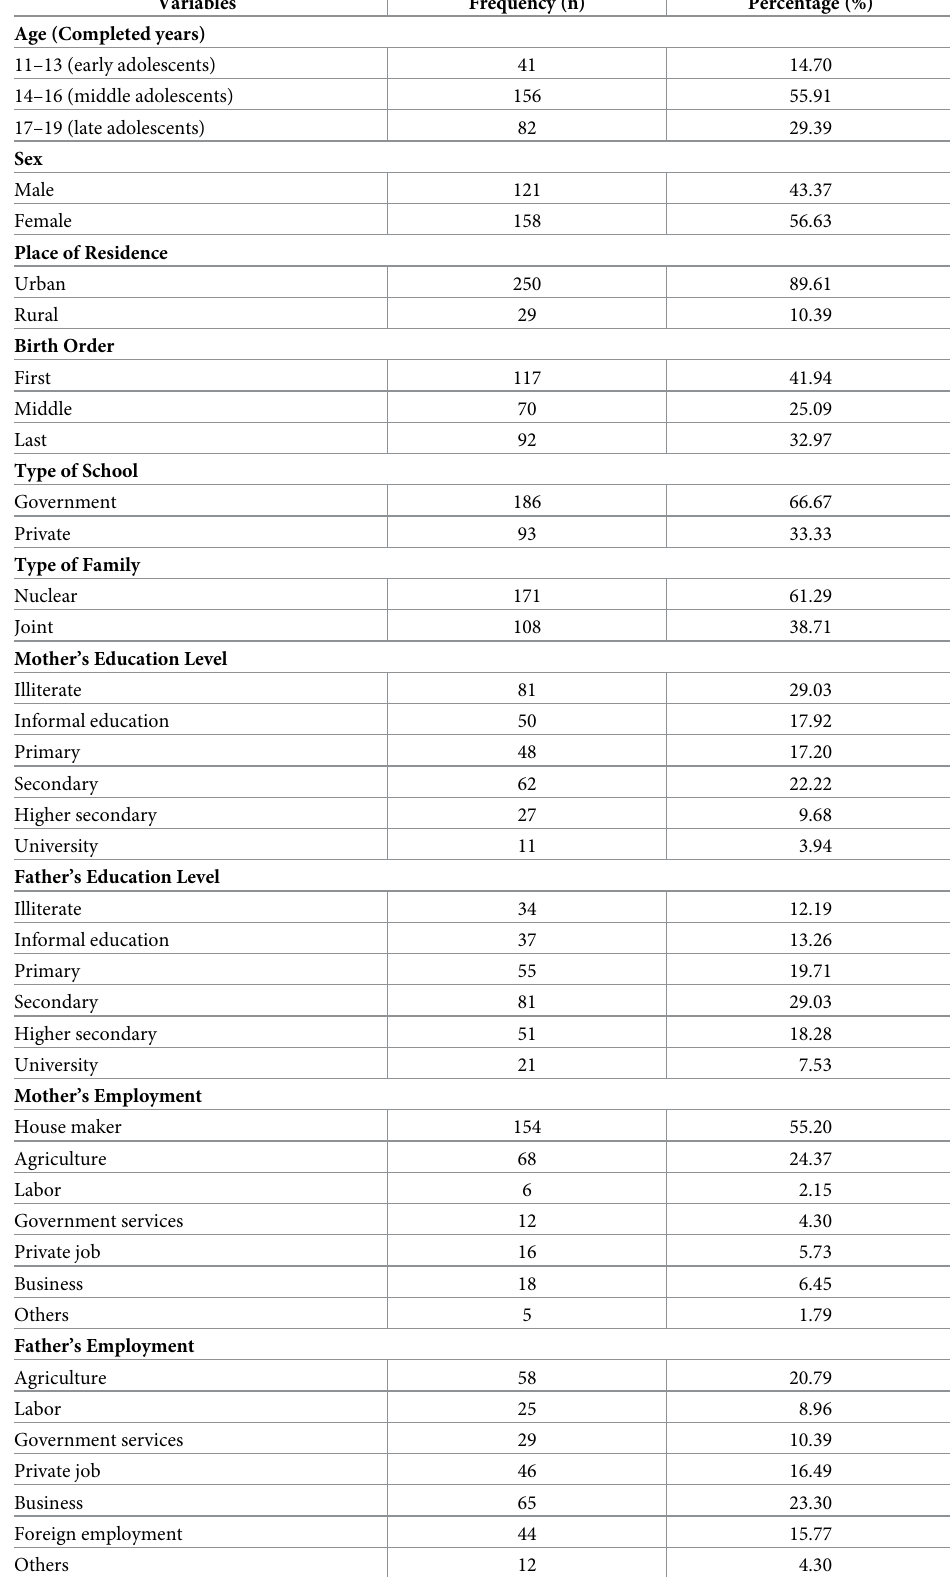
Table 1. Demographic characteristics of adolescents (n =